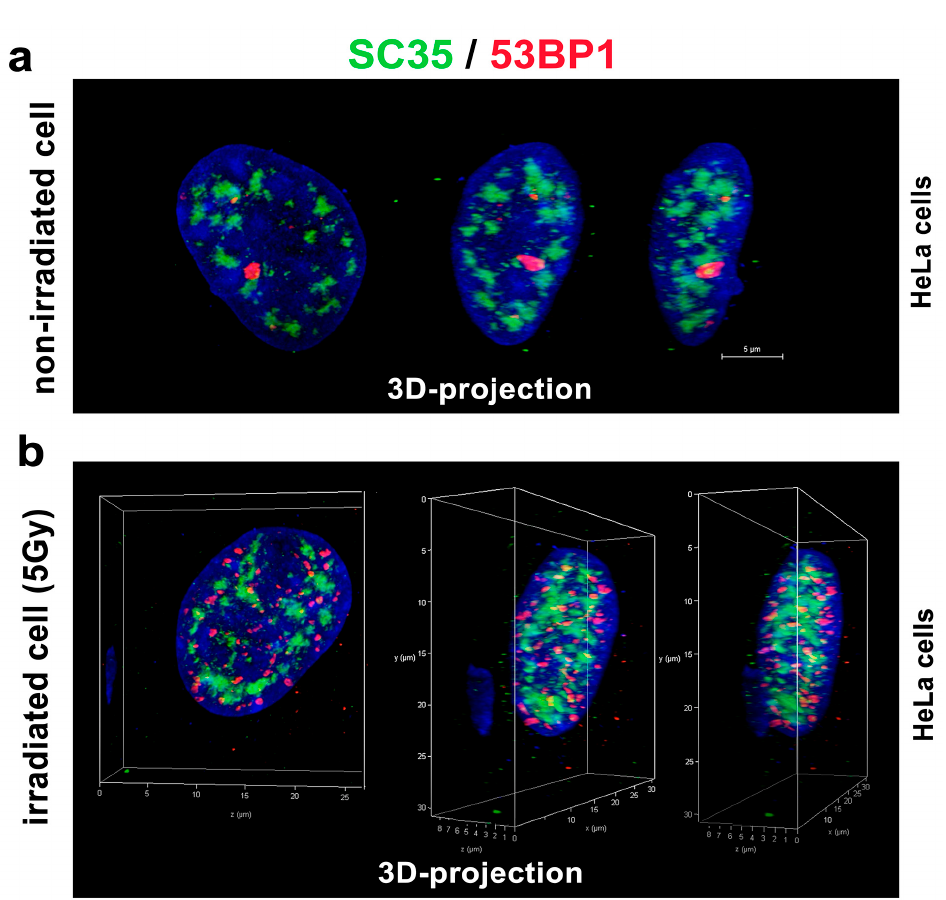
Figure 6. The 3D projection of SC-35 protein-positive foci and the DNA repair protein 53BP1 in HeLa cells’ nucleus. Nuclear distribution and mutual distance between SC-35 and 53BP1 proteins in ( a ) non-irradiated control cells, and ( b ) cells irradiated by 5 Gy of γ -rays. The deconvolution procedure was applied to these images. The 3D reconstruction of confocal images was performed by Leica LAS X software. Scale bar shows 5 μ m.